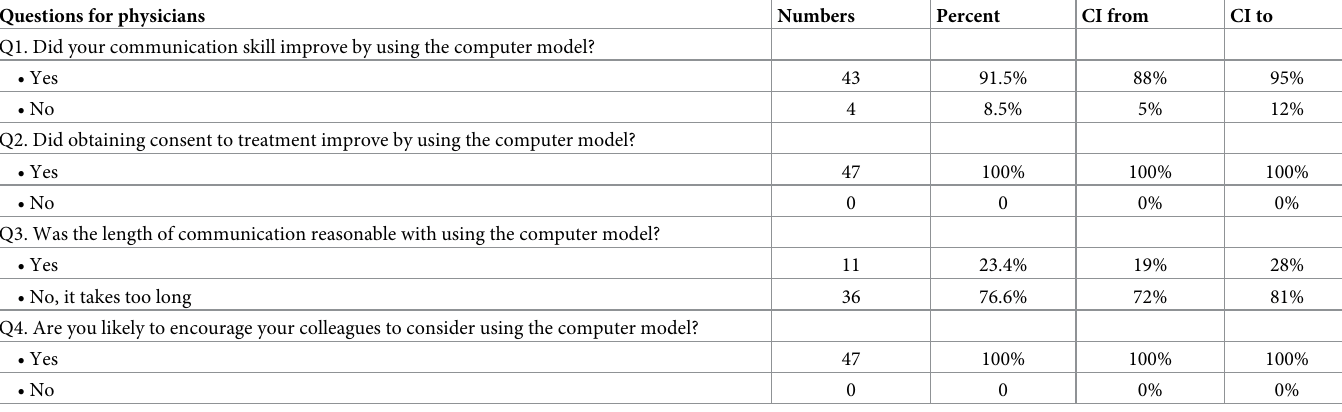
Table 2. Questionnaire for physicians (with 95% confidence intervals (CI)